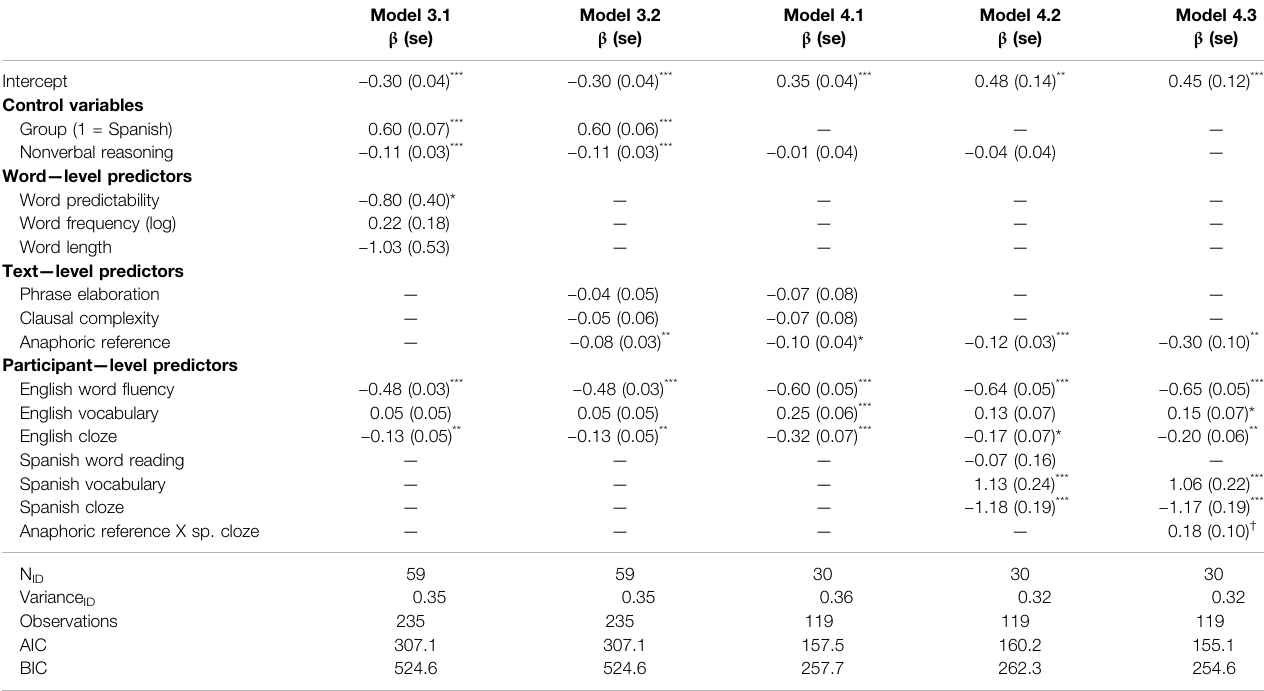
TABLE 8 | Results of fi tting a taxonomy of multi-level gaussian regression models for paragraph reading ef fi ciency (displaying standardized coef fi